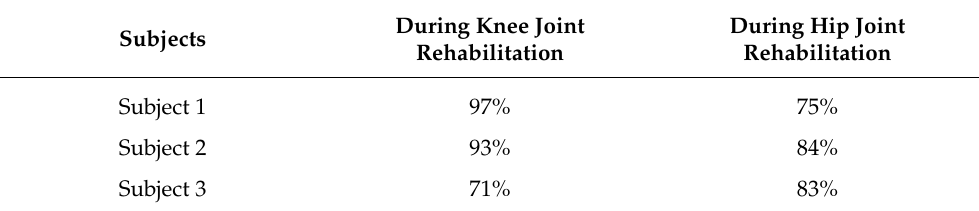
Table 12. Percentage decrease in EMG signals’ intensity during joint rehabilitation.